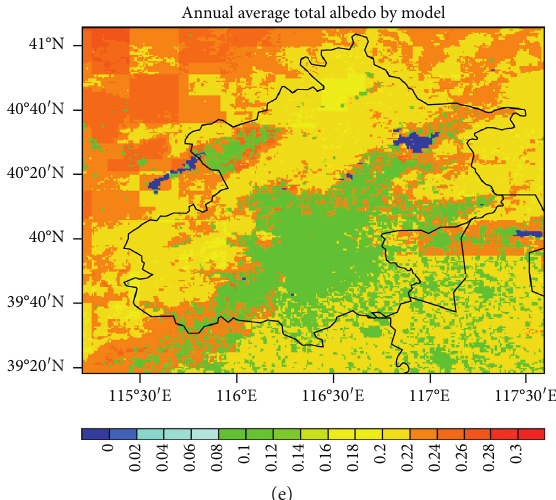
Figure 3: Spatial distribution of the annual (e) and seasonal (a–d) average surface albedo simulations before assimilation in the Beijing municipal area.